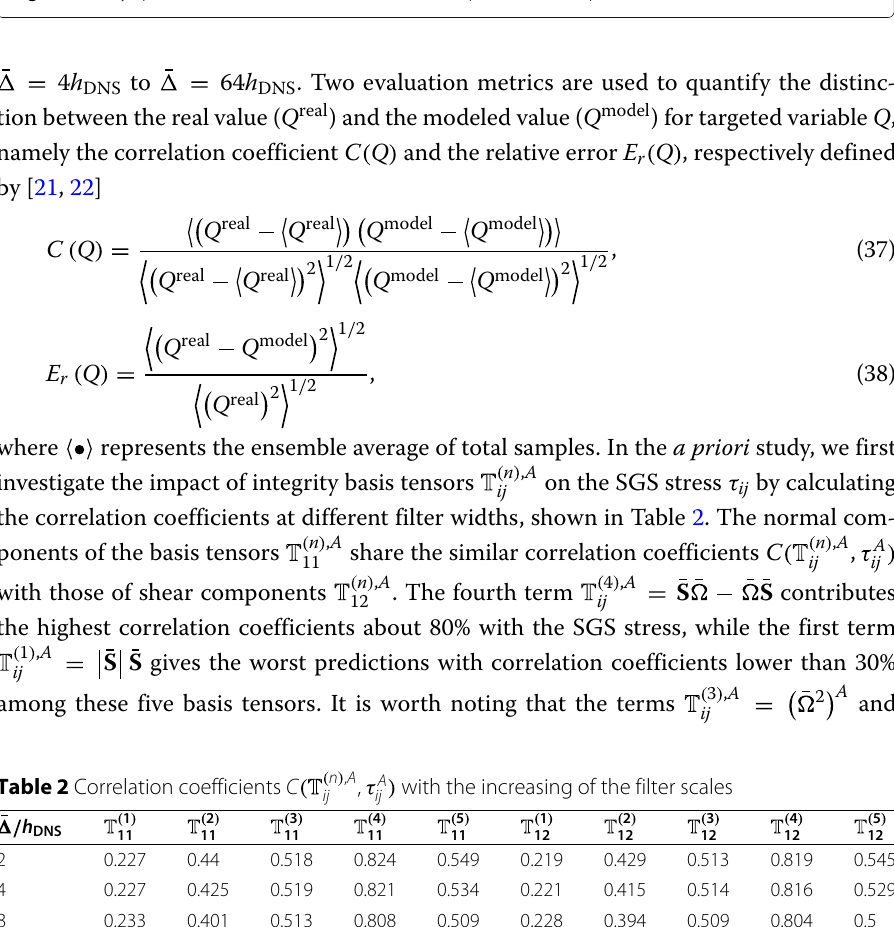
Fig. 1 Velocity spectra of DNS and filtered DNS for incompressible isotropic turbulence ( N 1024 3 )